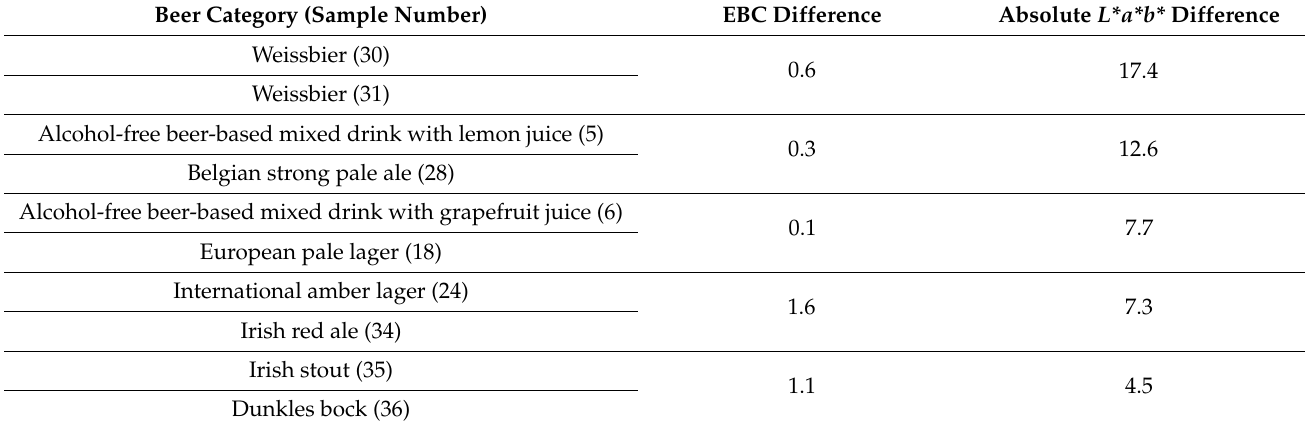
Table 17. EBC and color differences of beers.